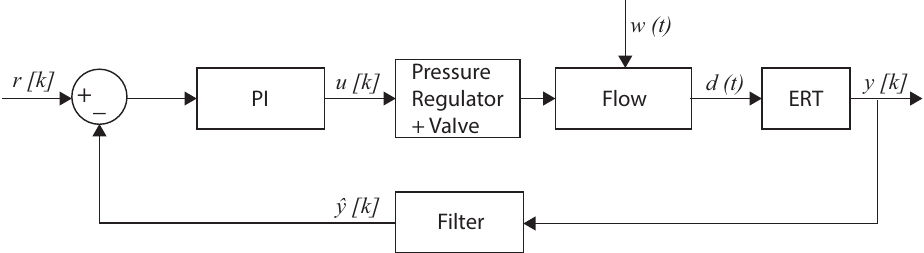
Figure 21. Closed loop block diagram with the ERT sensor and the PI controller. d ( t ) is the gas core size inside the installation (continuous-time signal), which is sampled by the ERT system as y [ k ] (discrete-time signal). The ERT signal is filtered into ˆ y , which is compared to a core-size reference ( r ), and the difference between the two quantities is used by the PI controller to compute the controller output, u . The variable w summarizes the unsteady effects of the core, due to the propagation of intrinsic dynamics from the upstream flow and to external process